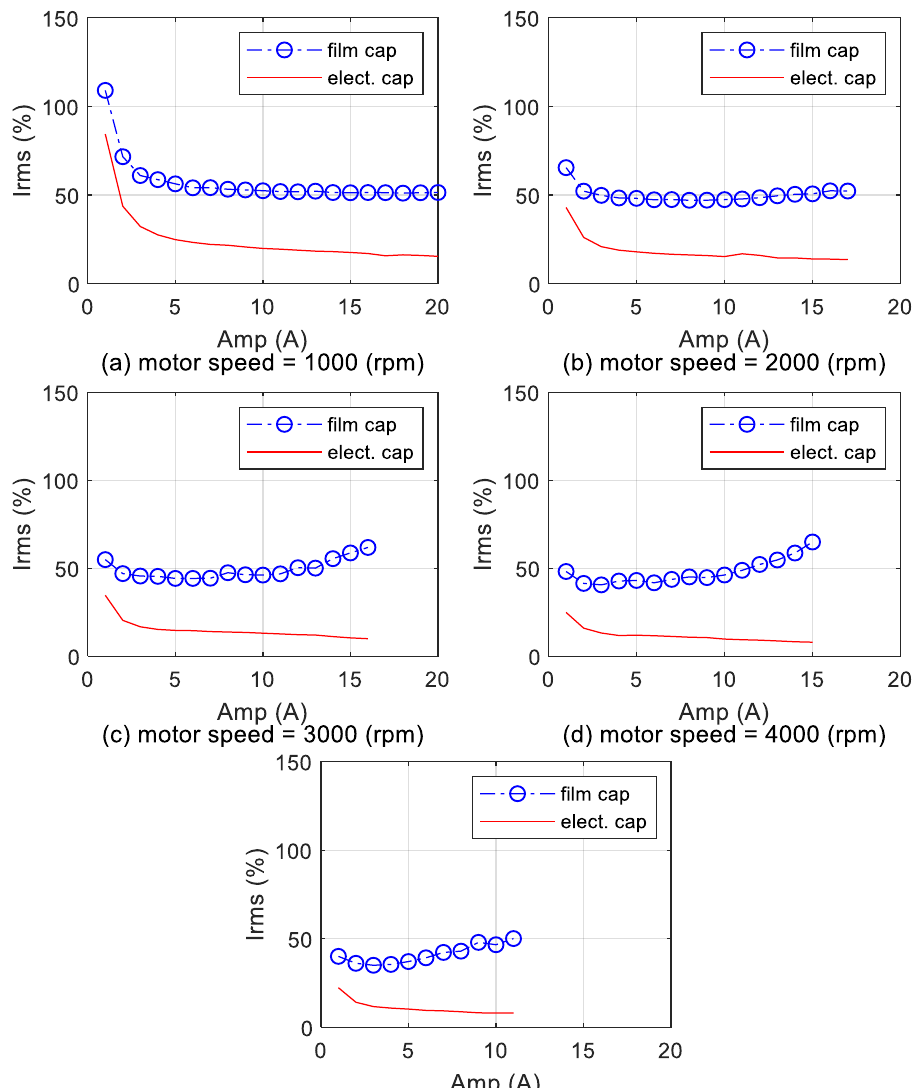
Figure 15. Percent RMS of DC-link currents of VSI with electrolytic ( a ) and film ( b ) capacitors as functions of speed and motor current.